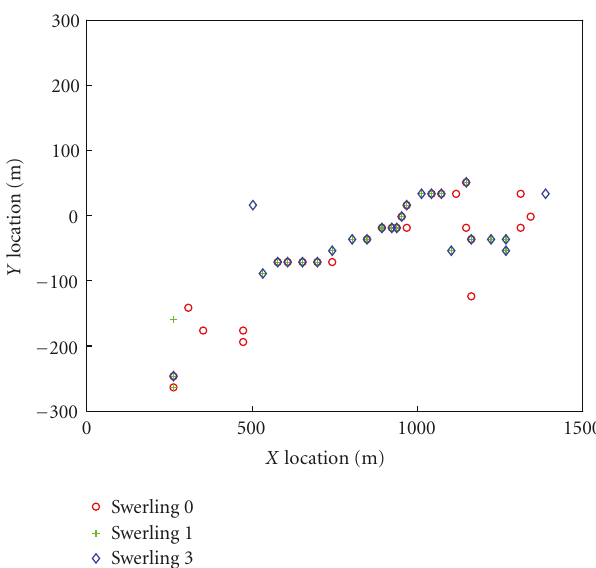
Figure 9: True target detections for Swerling 0, 1, and 3 target model when top three maximum localities are considered.